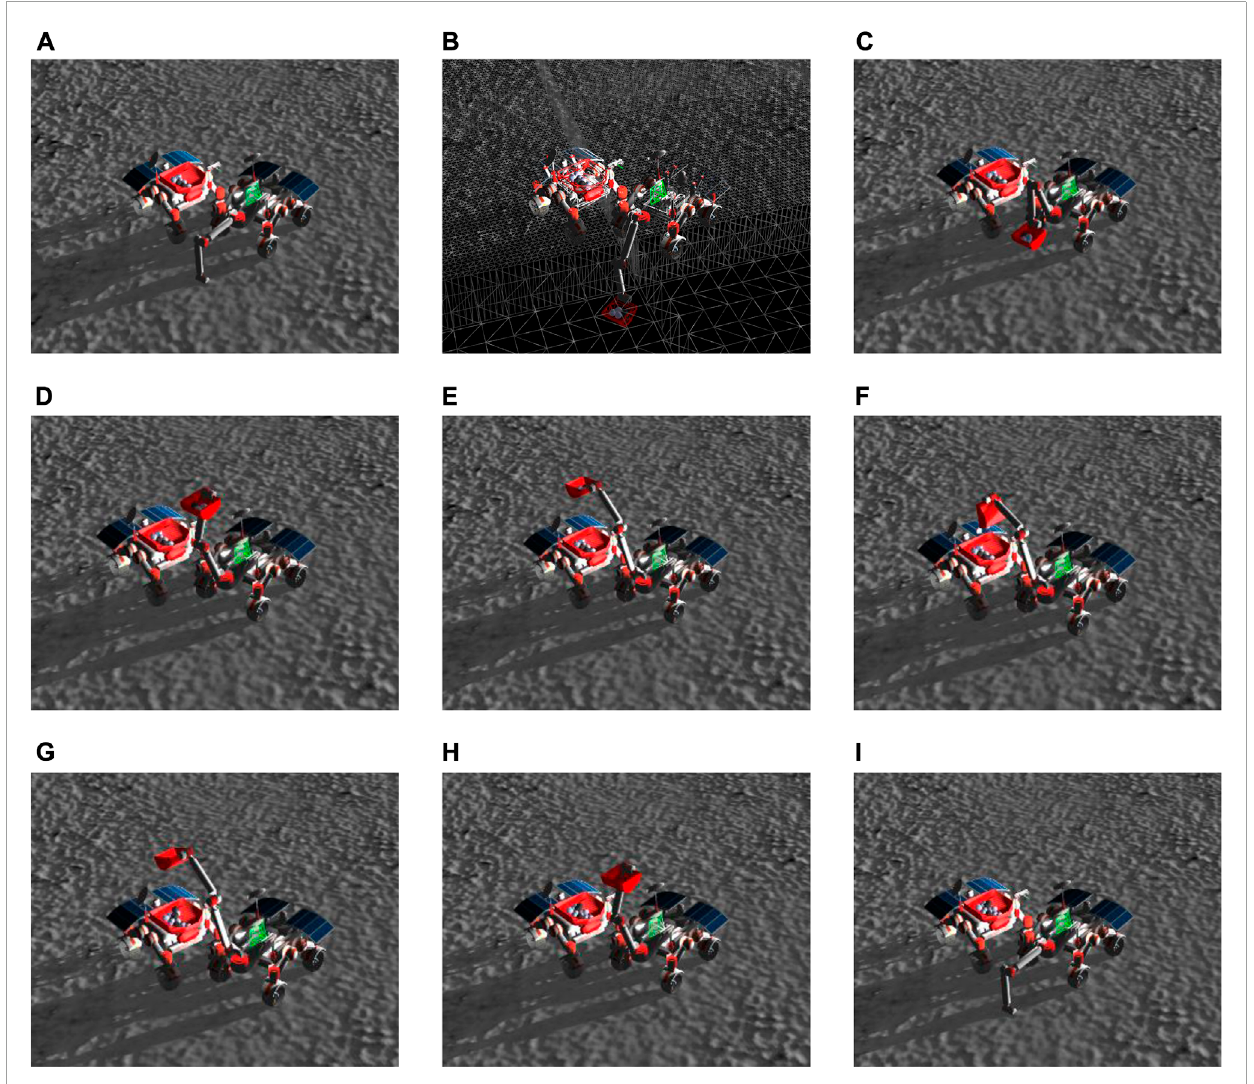
FIGURE 8 Excavation procedure is achieved by a sequence of actions followed by the Excavator’s arm. (A) The Excavator lowers its arm and identifies the position of the Hauler’s bin. (B) The arm is lowered to scoop for volatile clods, which are spawned 0.4 m below the terrain level. (C) The arm is taken to a Home position to prevent collisions with the Hauler’s wheels. (D) The arm is raised to avoid collisions with the Excavator’s camera when moving to a specific heading. (E) The arm is extended on top of the Hauler’s bin. The range and heading of the bin define the joint angles. (F) The bucket is emptied, and the volatile is dropped into the Hauler’s bin. (G) The arm is retracted to a safe position. (H) The arm is brought back to the front of the Excavator. (I) The process starts again. It loops until no more volatile is